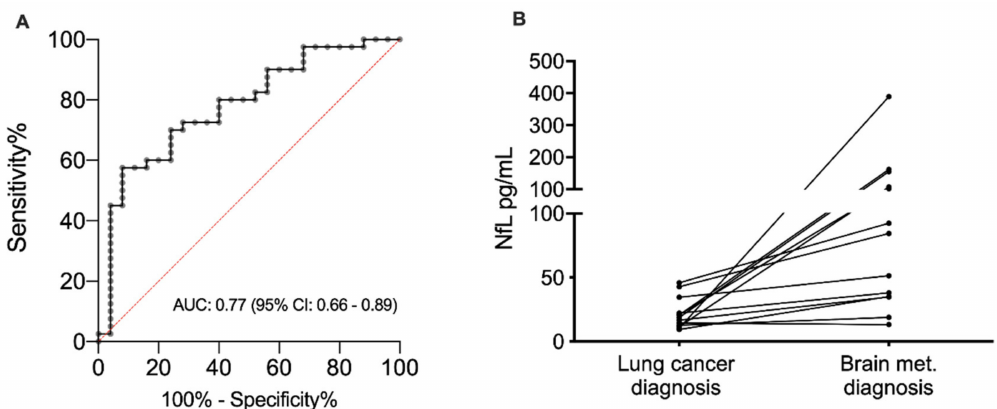
Figure 2. ( A ) Receiving operator curve showing the diagnostic value of the neurofilament light chain level separating non-small cell lung cancer patients with brain metastasis ( N = 43) and stage I non-small cell lung cancer patients ( N = 25). The diagnostic value is estimated by the area under the curve and presented with a 95% confidence interval. ( B ) Change in neurofilament light chain level from the time of lung cancer diagnosis to the time of brain metastasis diagnosis in lung cancer patients with available blood samples at both time points ( N = 13). Abbreviation: AUC, area under the curve; CI, confidence interval; NfL: Neurofilament light chain; met: metastasis.